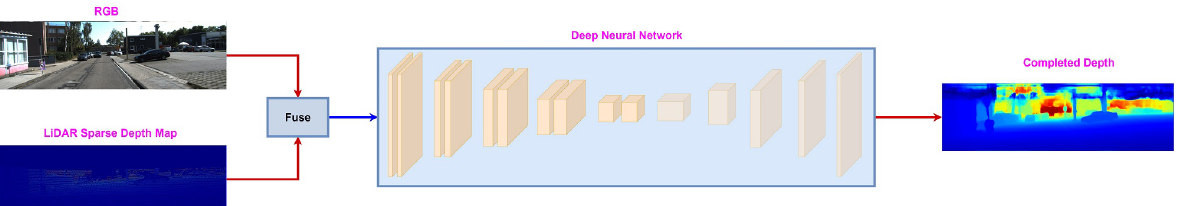
Figure 3. Early fusion between RGB image and LiDAR sparse depth. At first, both modalities are fused and then sent to the Deep Neural Network for dense depth